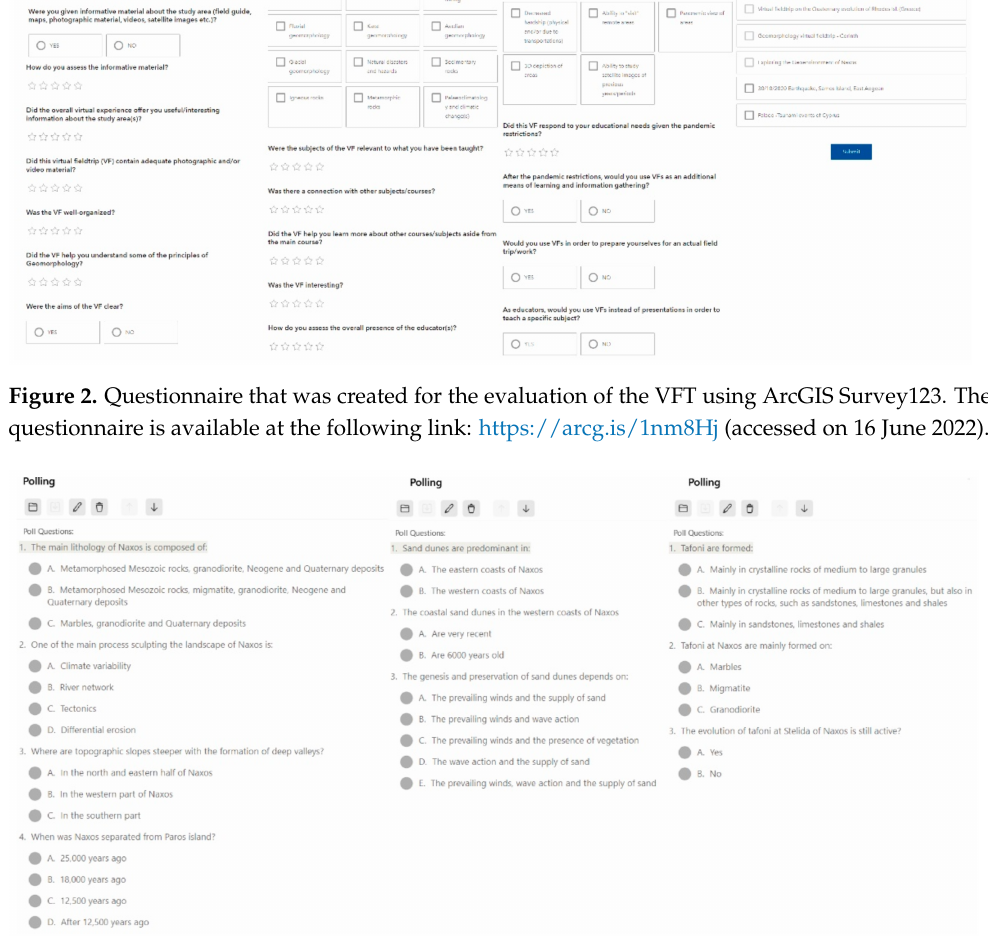
Figure 3. Quizzes that were used during the online